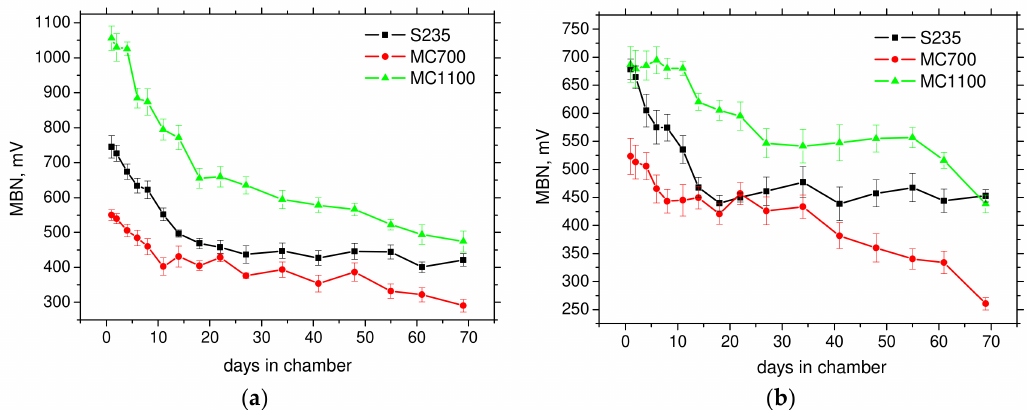
Figure 5. Evolution of MBN (rms) along the days in the chamber. ( a ) RD, ( b )